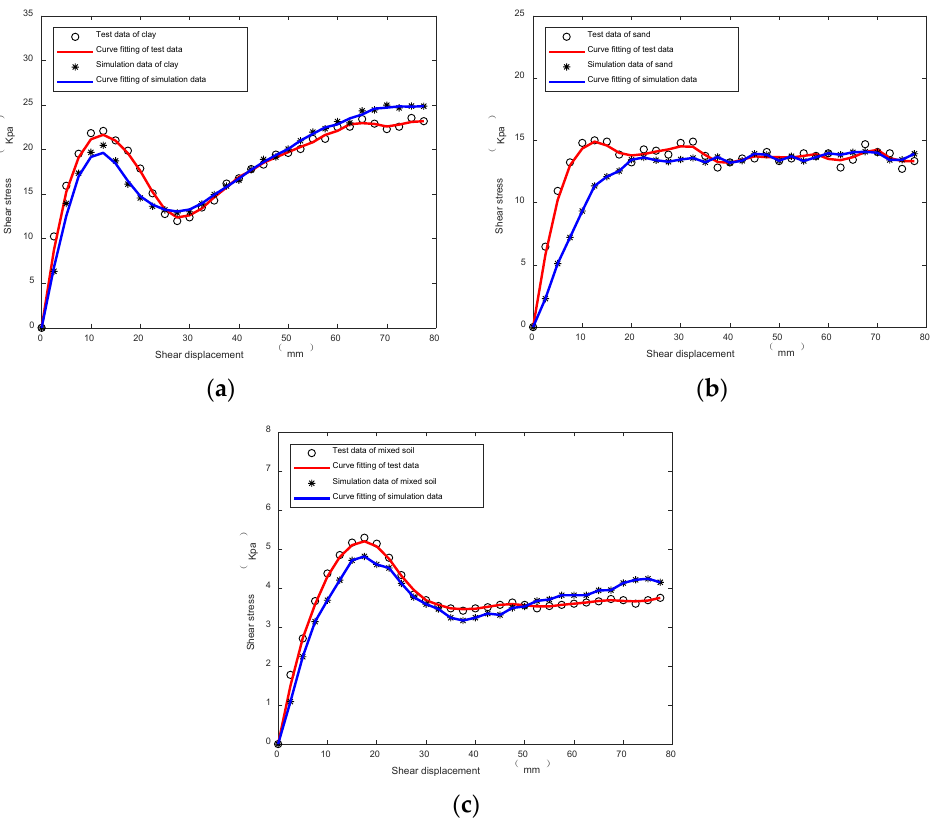
Figure 18. Curve fitting of shear stress–displacement in the test and simulation. ( a ) Trends in the test and simulation for clay. ( b ) Trends in the test and simulation for sand. ( c ) Trends in the test and simulation for mixed soil